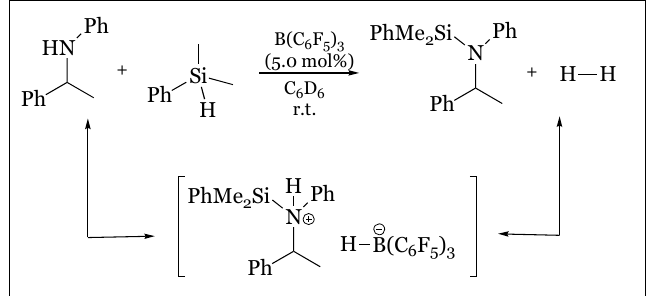
Figure 43. Nitrogen-silyl coupling mediated by tris(pentafluorophenyl)borane.